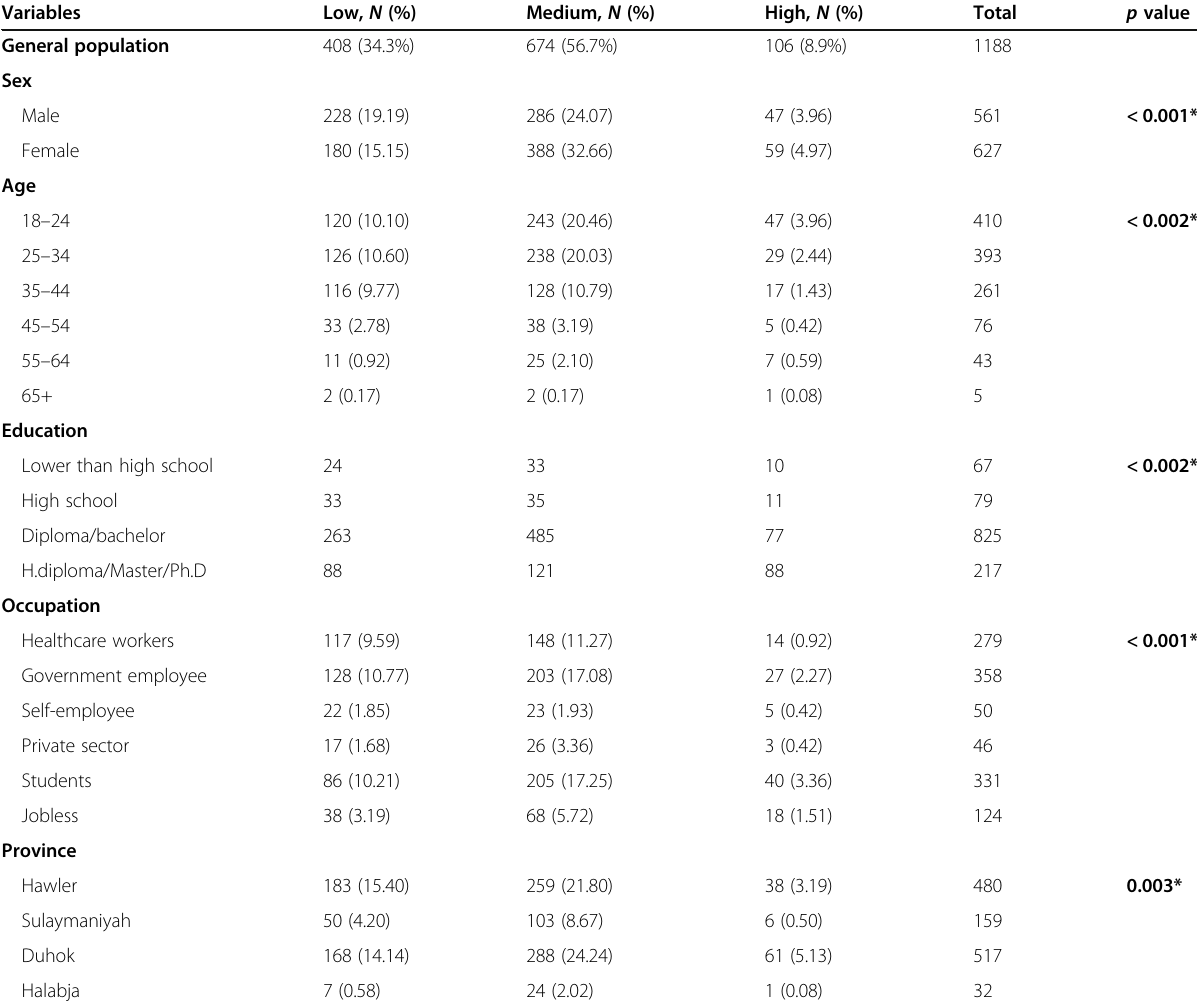
Table 1 Levels of fear according to socio-demographic characteristics during the COVID-19 vaccination